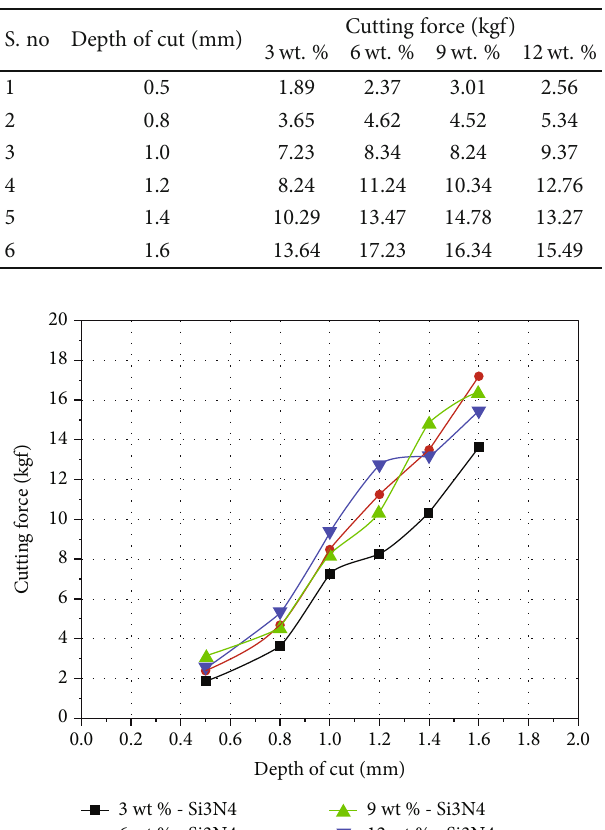
Table 7: Cutting force summary (cutting speed 150m/min).